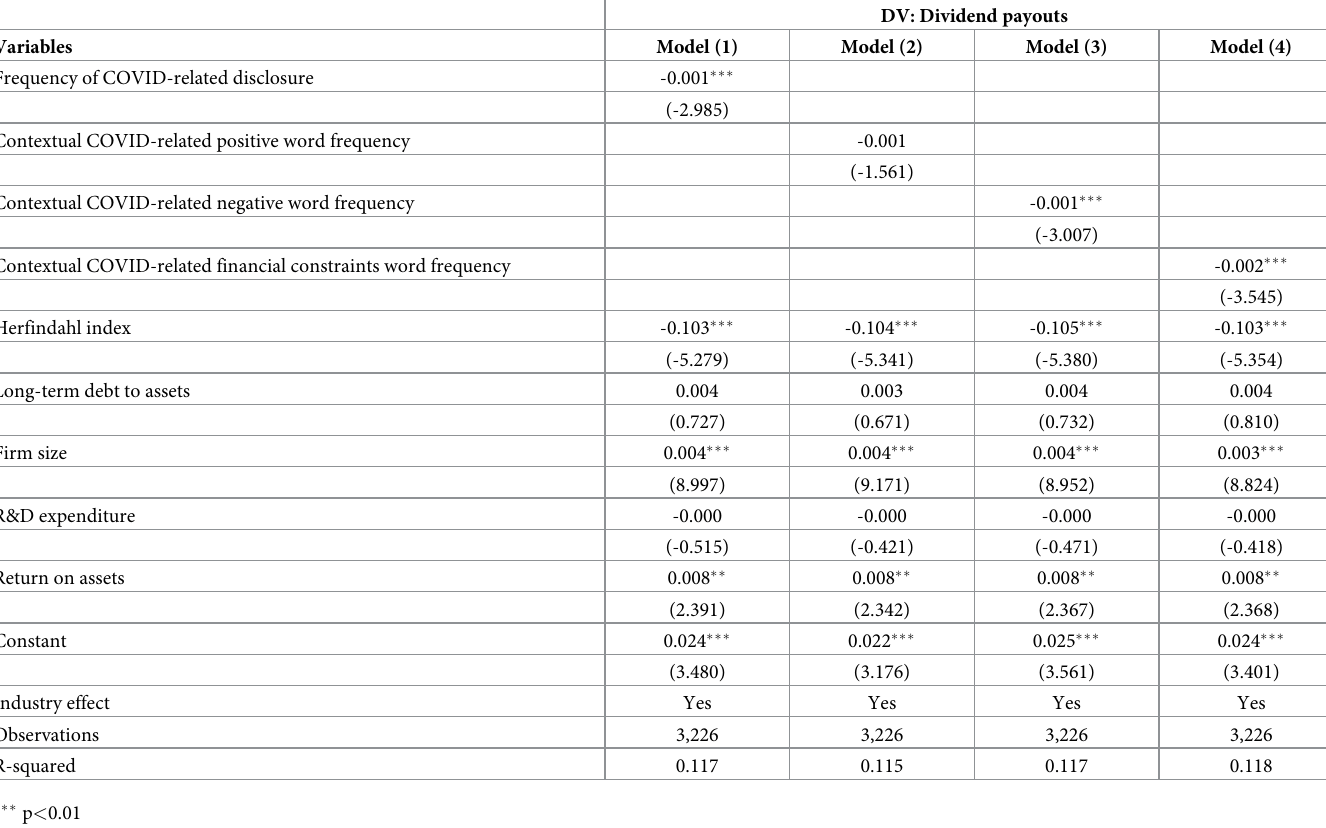
Table 5. Relationship between COVID-related disclosure and dividend